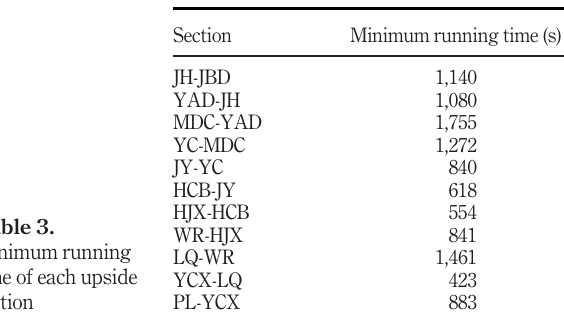
Table 3. Minimum running time of each upside